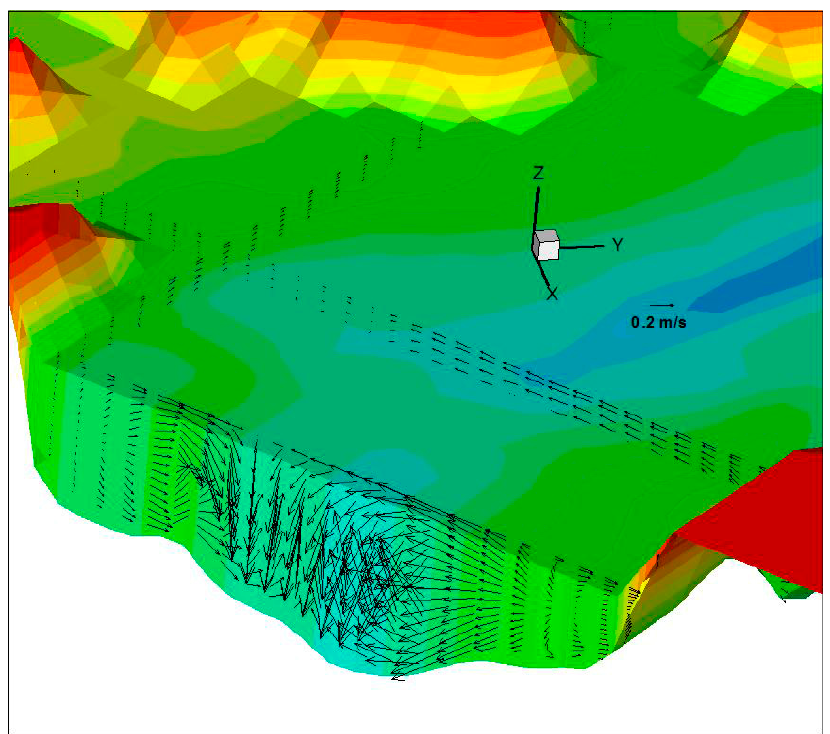
Figure 14. Computed velocity distribution in front of the dam (the discharge is 35,600 m 3 /s and water level is 135.1 m).